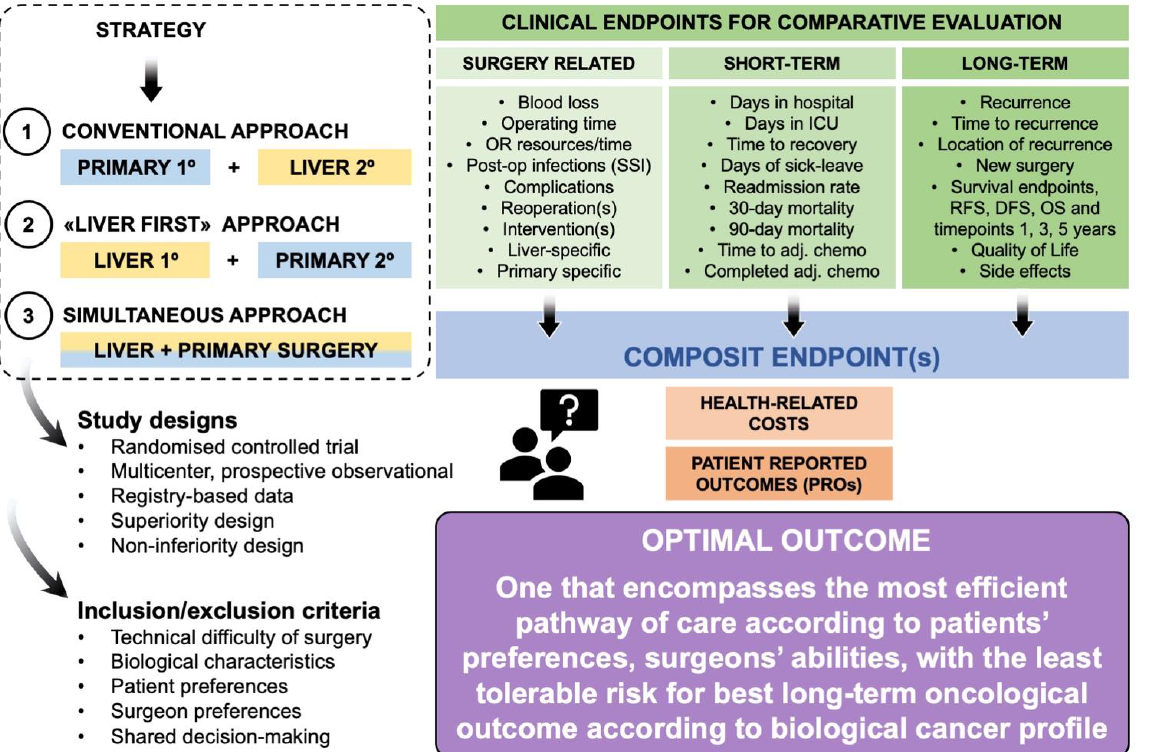
Figure 1. Schematic overview of different approaches for patients with colorectal cancer with synchronous liver metastases and clinical endpoints.